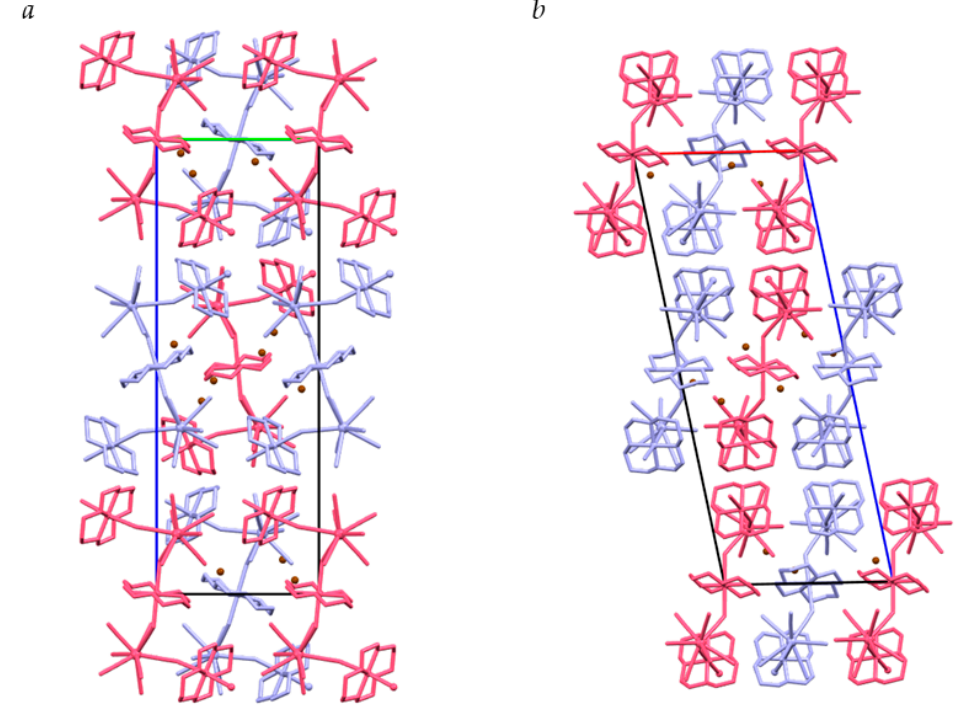
Figure 4. Projection of the structure of 2·3H 2 O along ( a , b ) crystallographic directions; symmetrically independent molecules marked pink and violet.